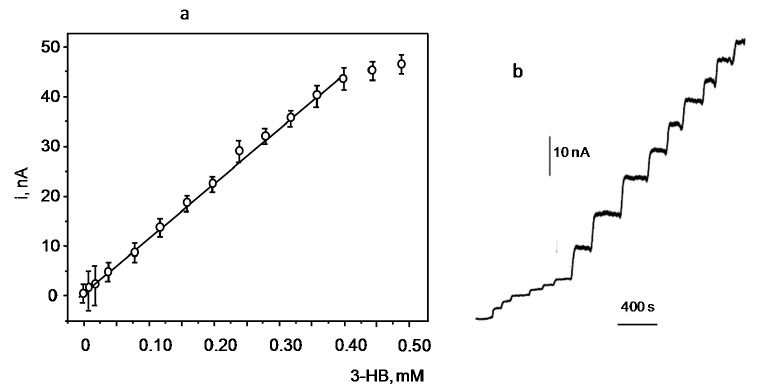
Figure 6. Calibration plot for 3-HB recorded with the 3-HBDH/THI/rGO/SPCE and some amperometric responses for additions of ( a ) 20 µ M and ( b ) 100 µ M 3-HB. Error bars are calculated according to ± s ( n =